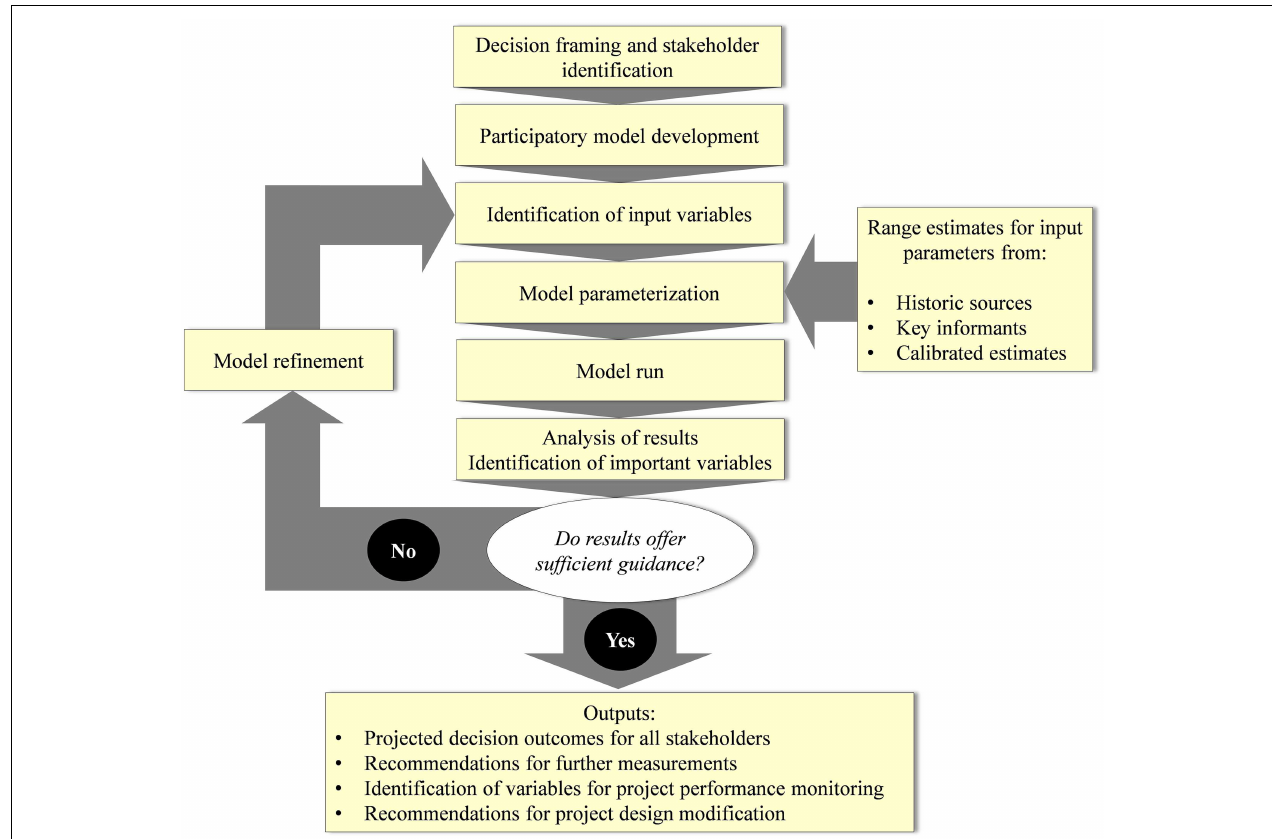
FIGURE 1 | Sequence of activities in the decision modeling